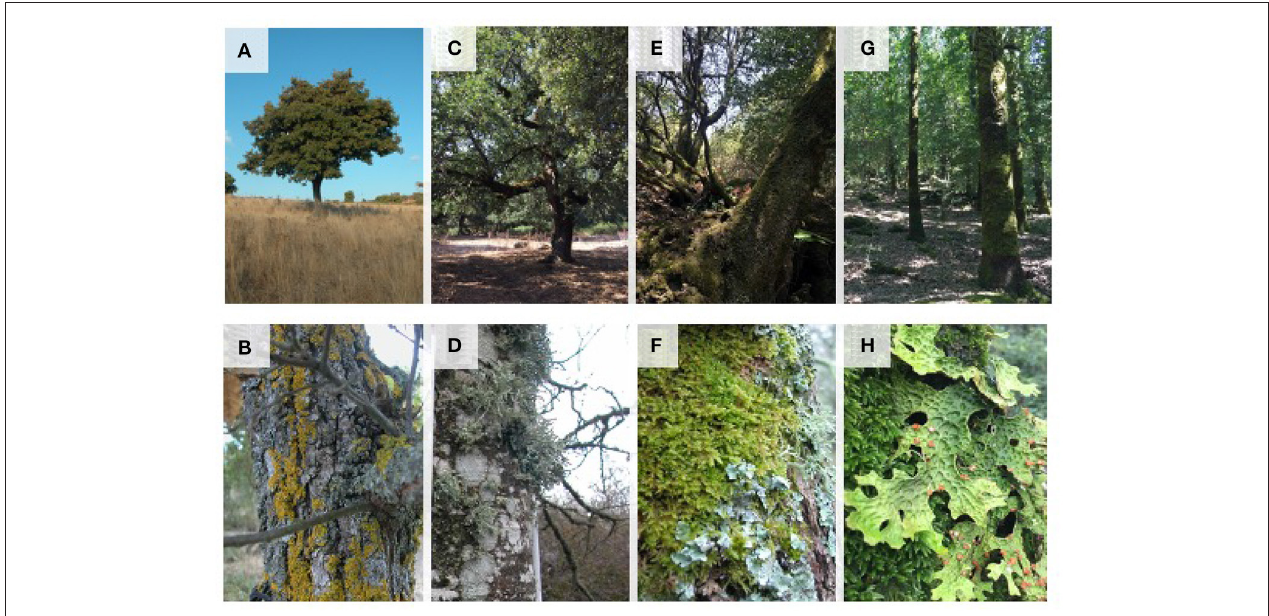
FIGURE 1 | Epiphytic NV vegetation in different habitats of the study area: isolated trees in open grassland areas (A) mainly colonized by xerophilous species of narrow-lobed foliose and crustose lichens (B) ; agroforestry areas with thermophilous oak woodlands (C) with species-rich communities of foliose, crustose, and fruticose lichens (D) ; open holm-oak forests in mountainous areas (E) with epiphytic communities of bryophytes and hygrophilous foliose lichens (F) ; mature holm-oak and downy oak forests (G) colonized by extensive mossy mats and large foliose lichens of the genus Lobaria (H)